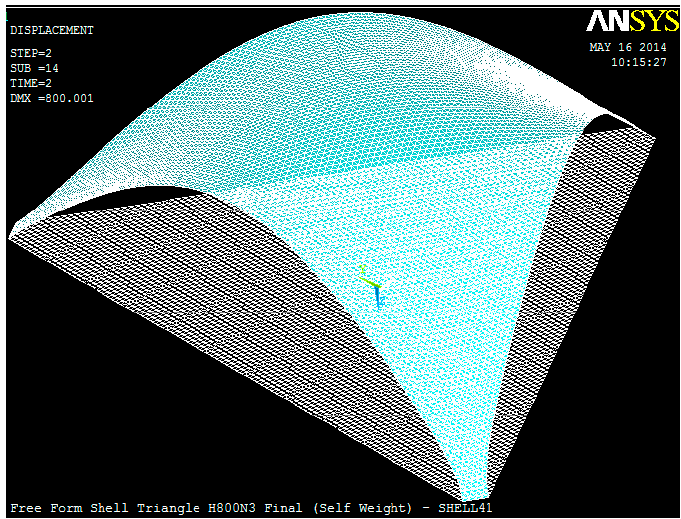
Figure 14. Free-form shell generated using a geometrically nonlinear analysis [10].